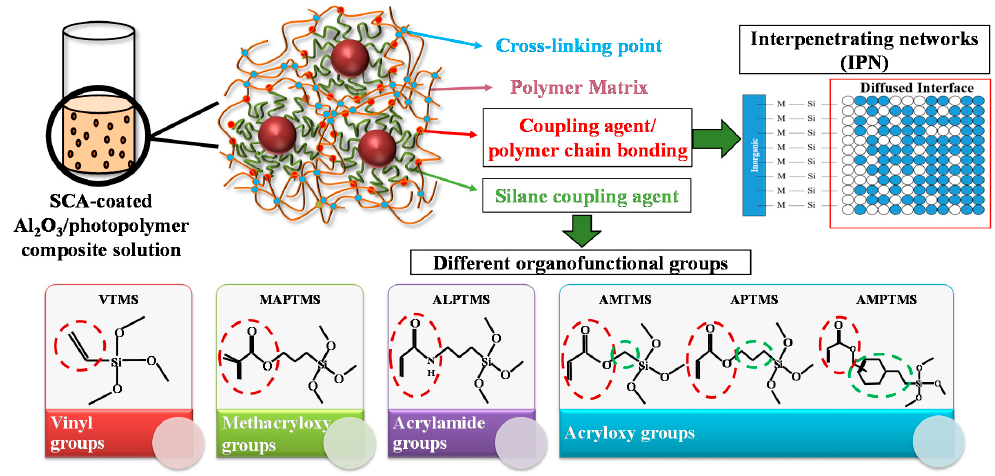
Figure 1. Schematic illustration of dispersion principles of ceramic particles with different organofunctional groups in a photopolymer solution.